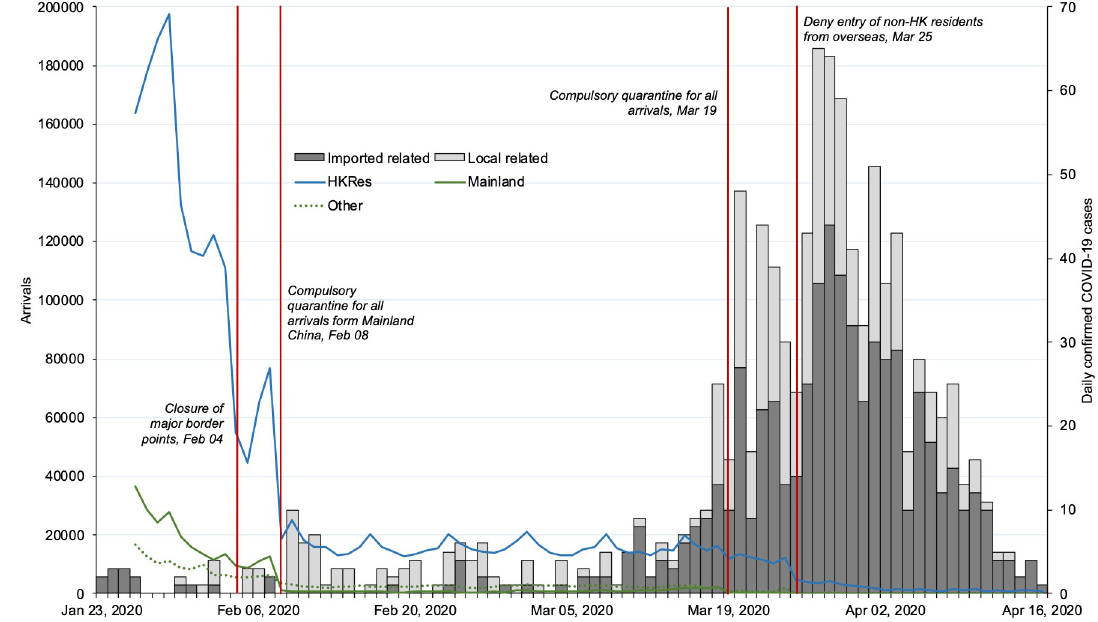
Fig 4. Number of arrivals (primary axis) and daily confirmed cases by residential status (secondary axis: Hong Kong (n = 1,017, January 23 to April 16, 2020 [arrivals data only available from January 24, 2020]). Data Source: Hong Kong